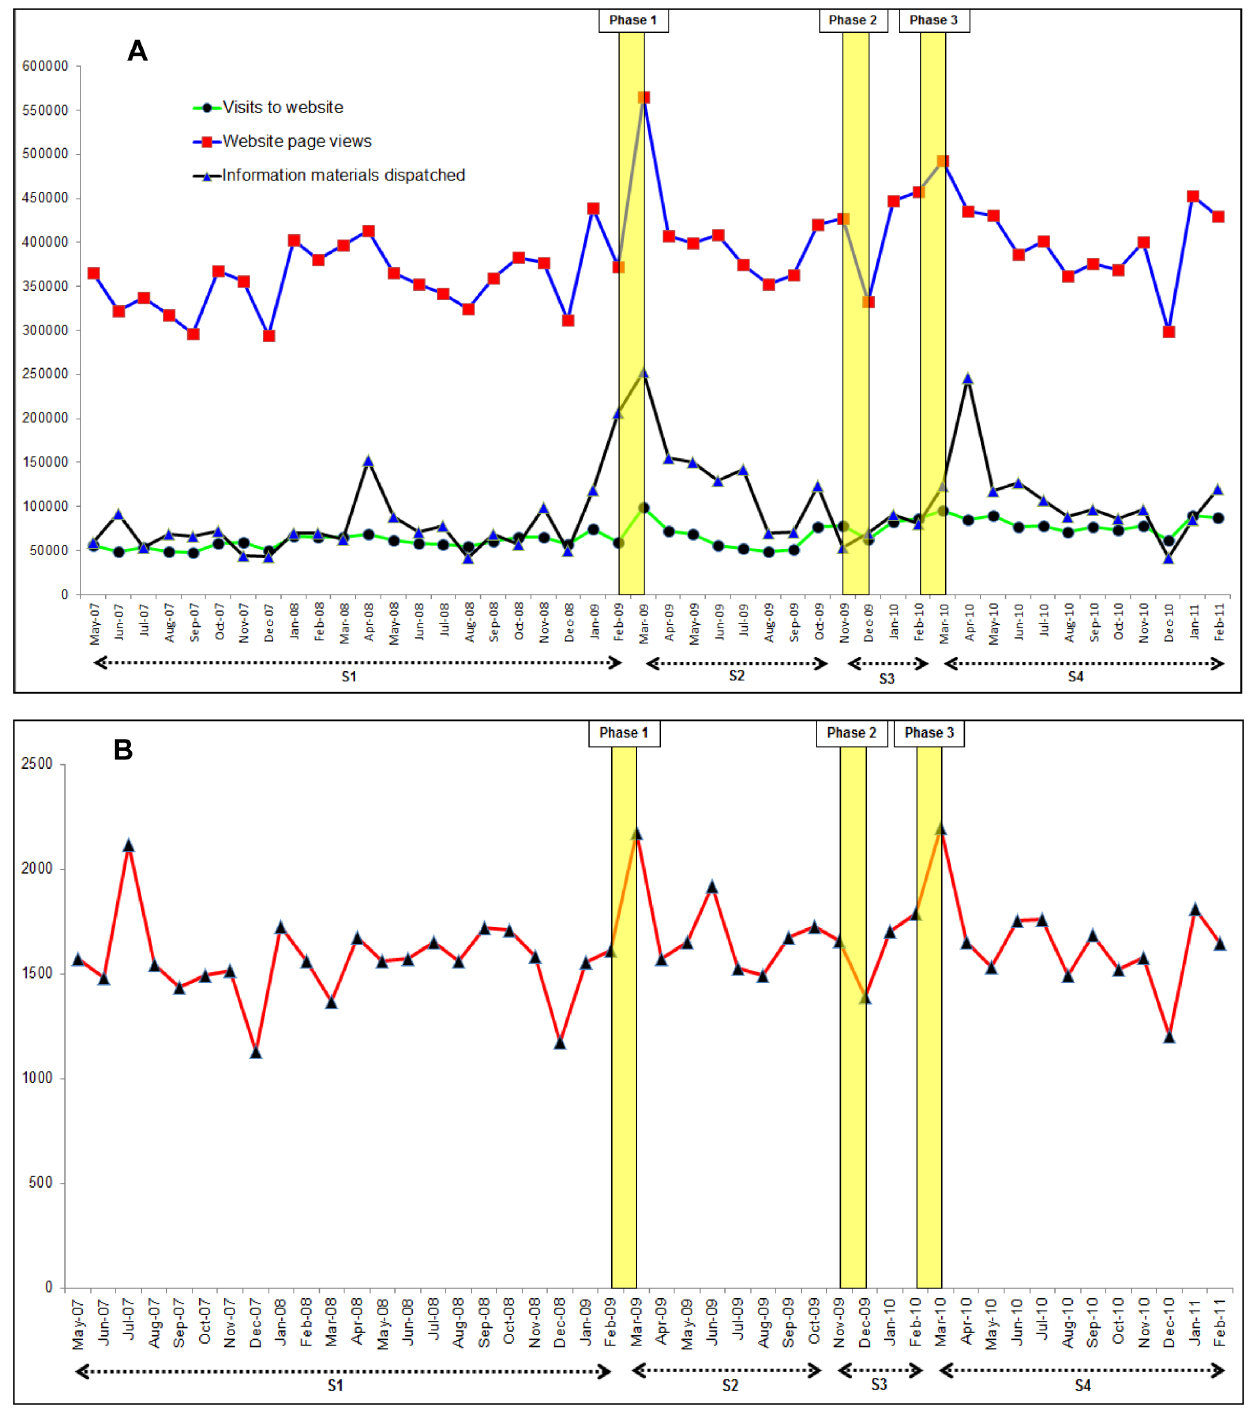
Figure 1. Time series graphs of monthly resource utilisation by the Stroke Association over the study period (May 2007 to February 2011). A: Absolute numbers of website page views, website hits and information materials dispatched by the Stroke Association. B: Absolute numbers of telephone calls received by the Stroke Association helpline. S1: period before the campaign (May 2007 to Feb 2009). S2: period of no campaign activity after phase one of the campaign (Mar 2009 to Oct 2009). S3: period during phases two and three of the campaign (Nov 2009 to Feb 2010). S4: subsequent period with no campaign activity after phase three (Mar 2010 to Feb 2011). Yellow vertical bars represent the time periods for the different phases of campaign activity.